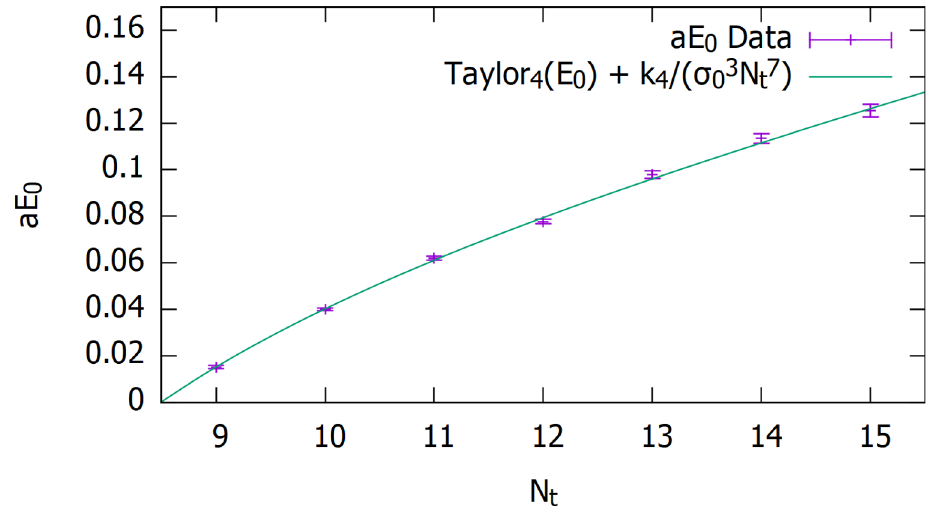
Figure 8 . Same as in figure 7, but for β = 12 . 15266 .